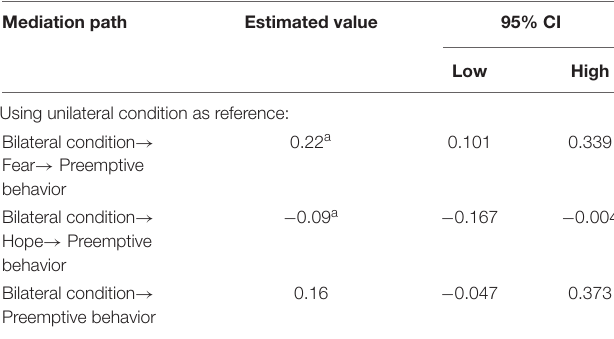
TABLE 4 | Mediational model wherein fear and hope underlie the effect of bilateral/unilateral condition on the preemptive behavior. Mediation